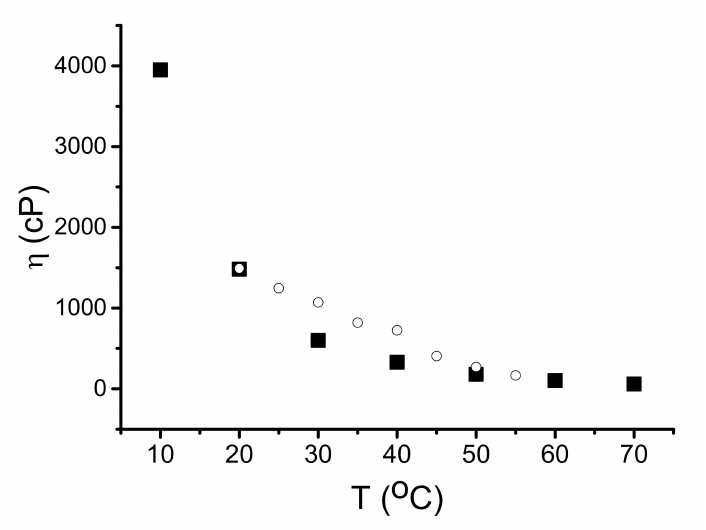
Figure 7. Temperature dependence of glycerin viscosity measured in the paper (circulars) by using Lamb mode with frequency 49.74 MHz in ST,X-quartz plate with h/ λ = 1.0 and the same dependence taken from [39] (squares). Precision of our measurements is ±